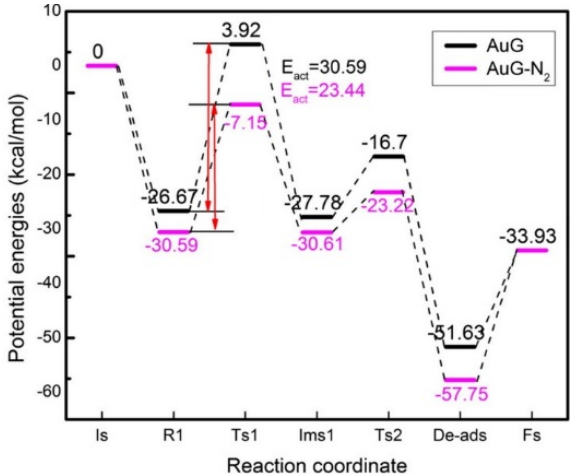
Figure 8. Energy diagrams of acetylene hydrochlorination on AuG and AuG–N 4 spheric active carbons (SACs) [76].